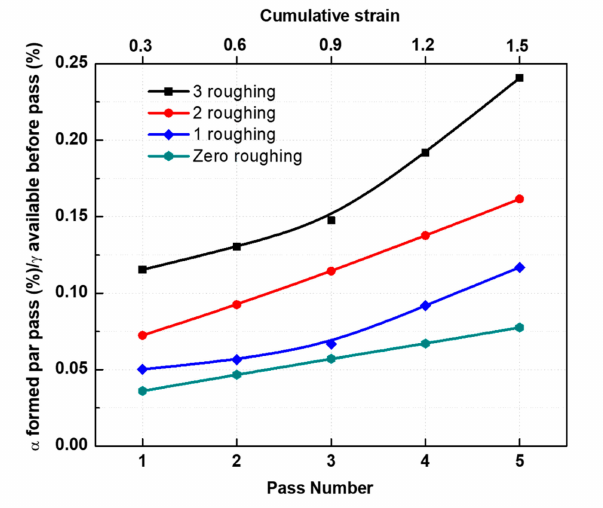
Figure10. Thedependenceoftheproportionofausteniteavailablefortransformationthatistransformed into ferrite on pass number. The ratio increases sharply when the number of roughing is